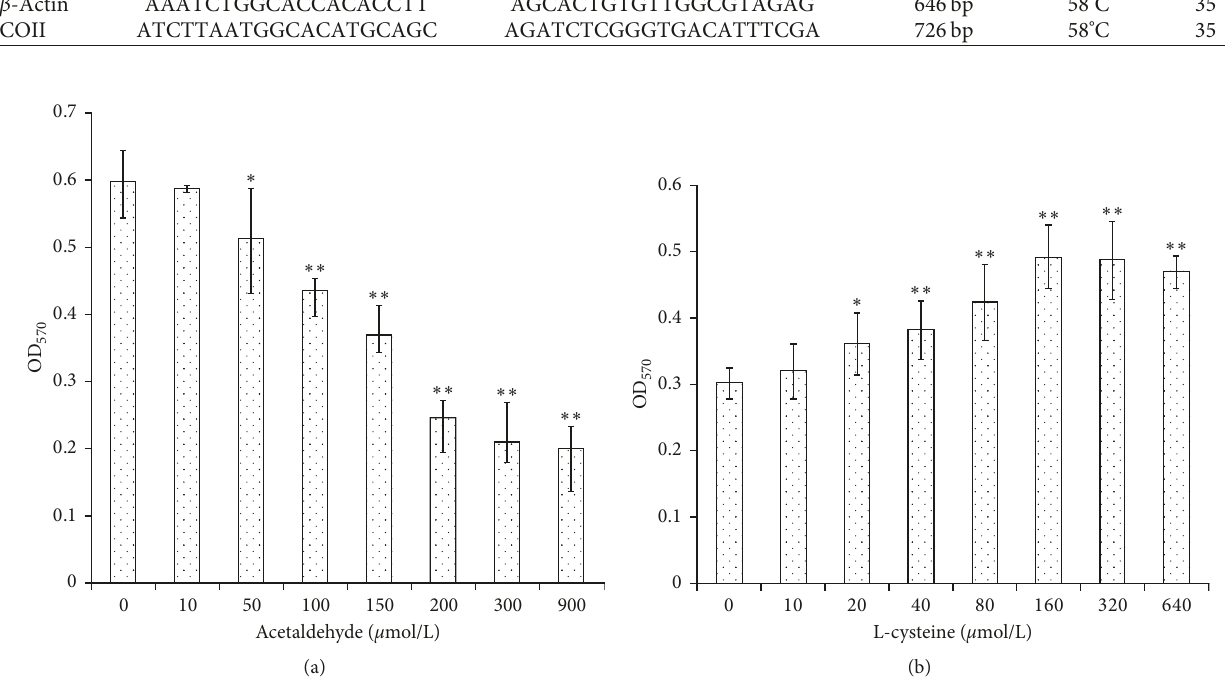
Figure 1: Cell viability of A549 cells influenced by acetaldehyde (a) and influence of L-Cys on cell viability of A549 cells damaged by 200 μ mol/L acetaldehyde (b). Data are represented as the mean